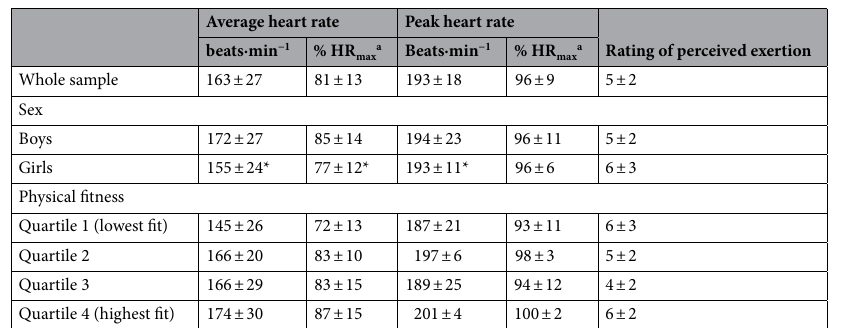
Table 2. Participants average and peak heart rate during The Daily Mile, and rating of perceived exertion. a The percentage of age predicted maximum heart rate (HR max ) during The Daily Mile. HR max predicted based upon (HR max = 208–0.7[age]) 25 . *Boys > girls, all p <